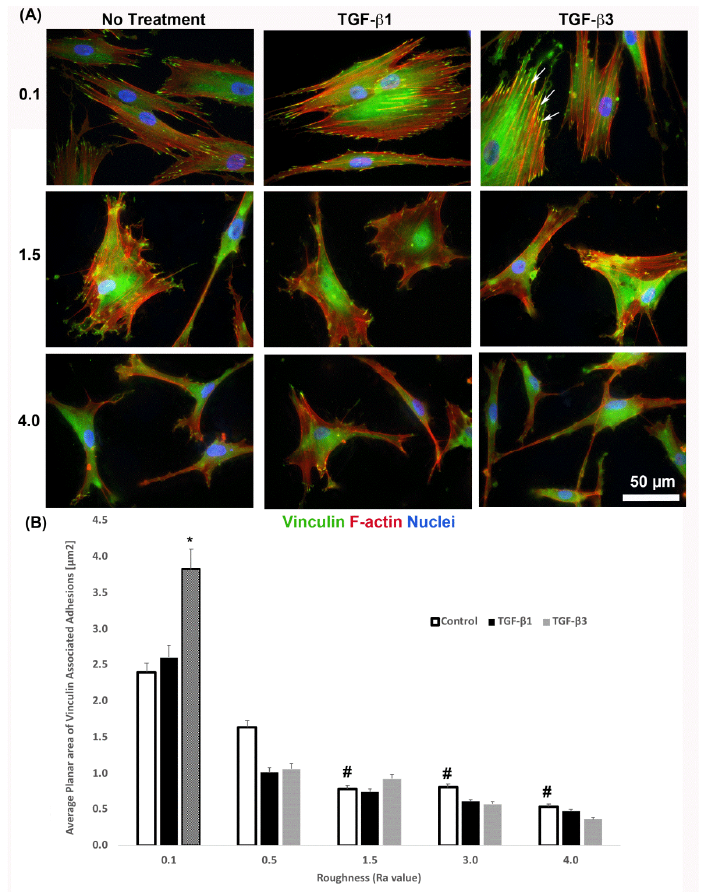
Figure 7. Influence of TGF- β isoforms on adhesion size in HGFs. ( A ) Immunocytochemistry for vinculin (green) and F-actin (red) in cells on 0.1, 1.5 and 4.0. Representative images are shown. TGF- β 3 increased vinculin plaque size (denoted by white arrows). ( B ) Quantification of